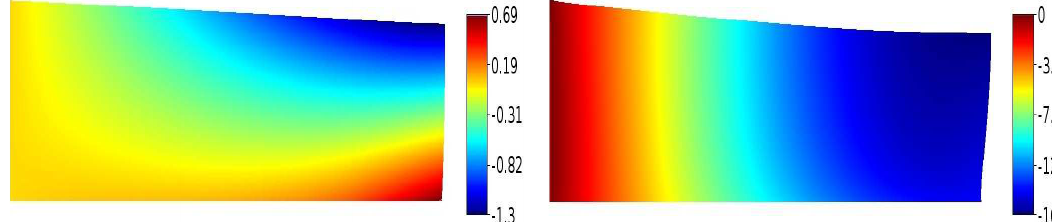
Figure 3. Electric potential in the case of an insulated foundation (left) and in the case of a conductive foundation